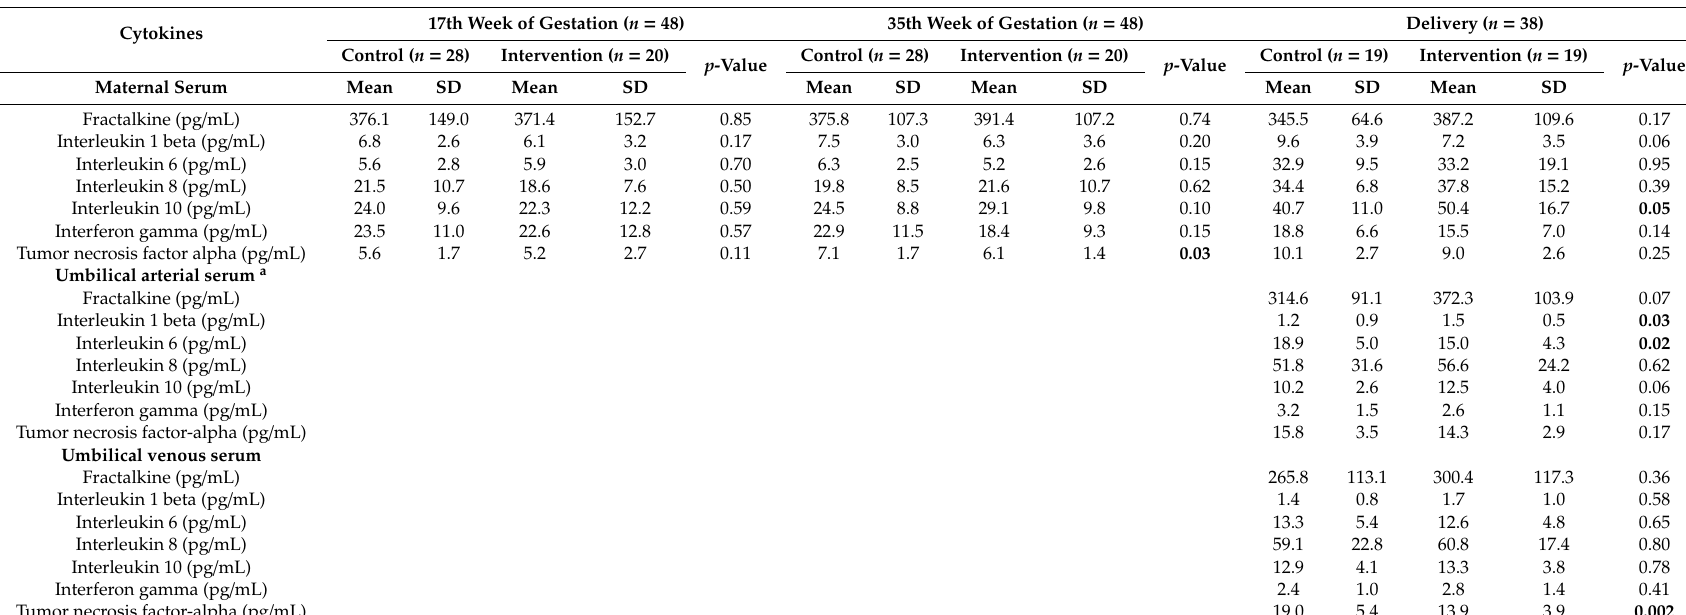
Table 2. Cytokines concentrations at the three time points ( n =